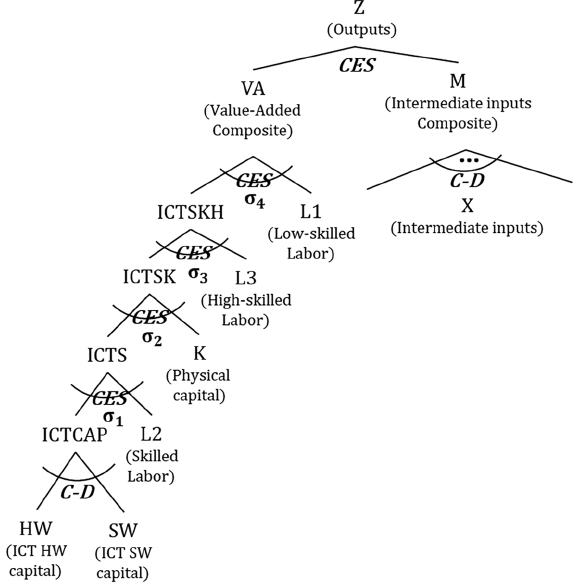
Figure 1. Production structure of final